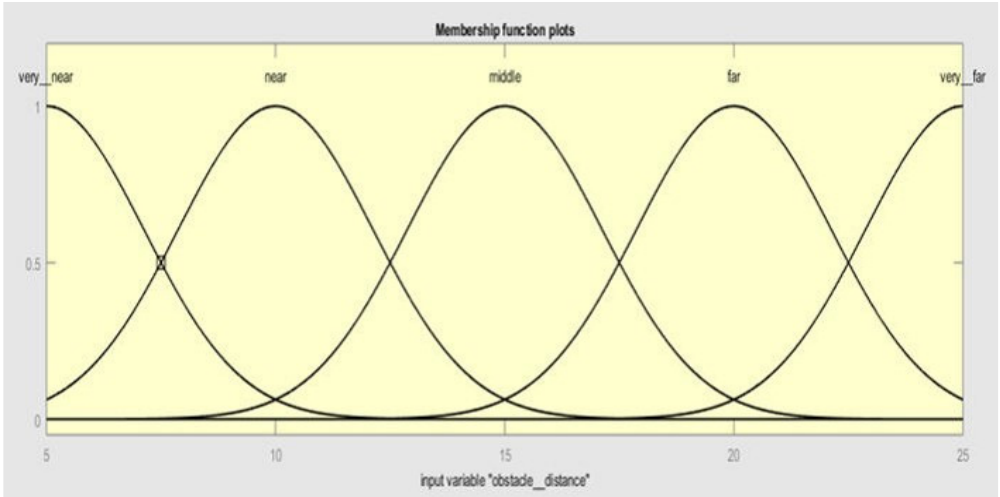
Figure 5. Membership functions for input 1 (obstacle distance).